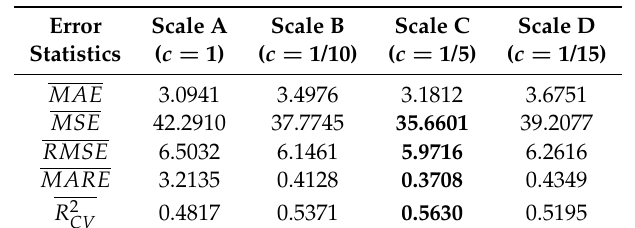
Table 3. Error statistics for the PM 2.5 data set using the shape function-based extension method and 10-fold cross validation after removing outliers.